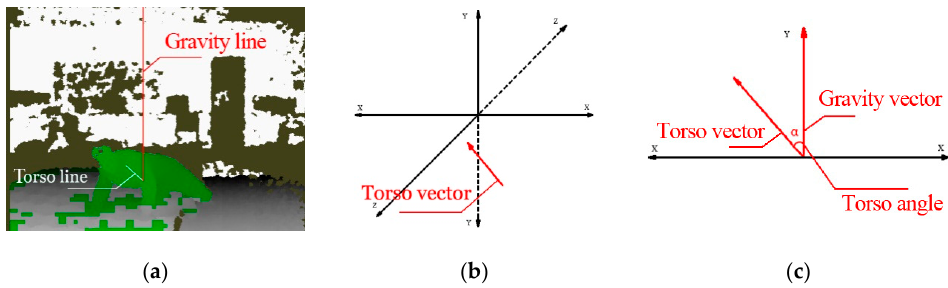
Figure 3. The process of extracting torso angle from a depth image. ( a ) A depth image fetched from a middle frame in a fall video; ( b ) torso vector represented in 3D coordinates; ( c ) torso angle represented in a 2D plane after vector translation.